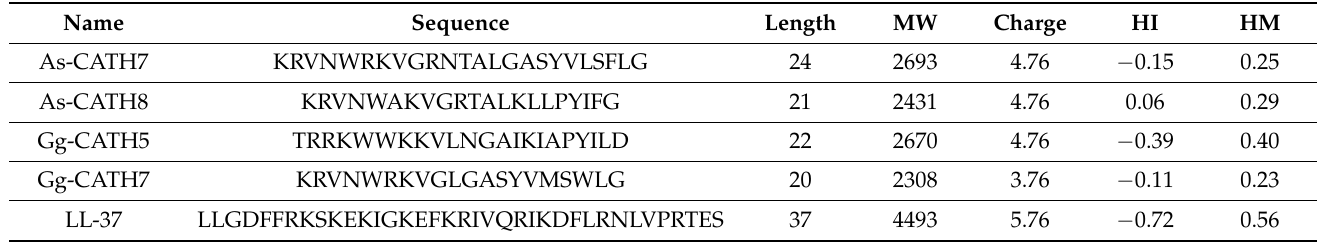
Table 1. Physicochemical properties of synthetic croCATHs and human LL-37. Properties were calculated using the Peptides and modlAMP packages in R and Python, respectively.